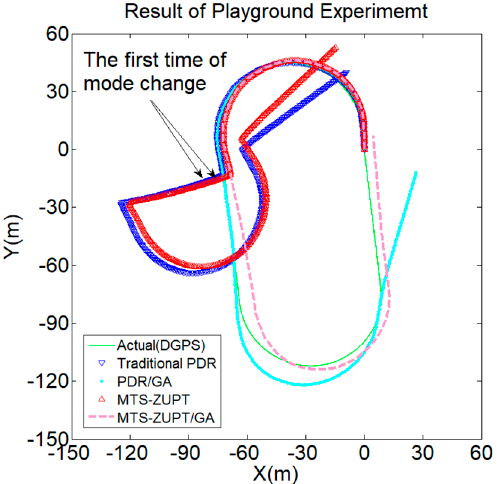
Figure 14. Result of Playground Experiment.